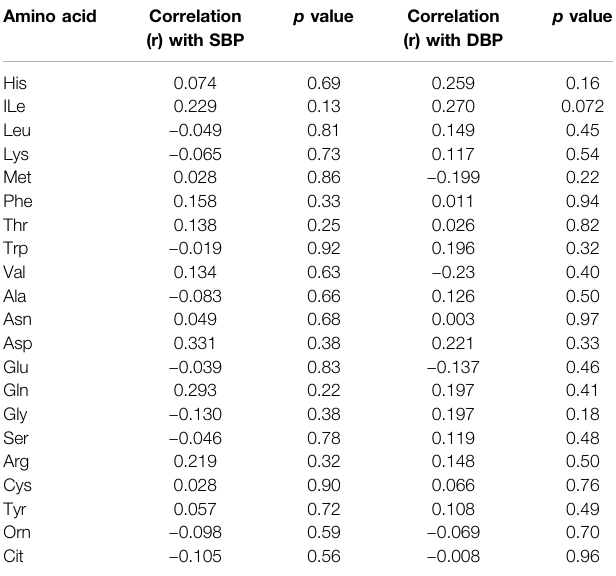
TABLE 6 | Correlation analysis between blood pressure and amino acids concentrations in T2D. Amino acid Correlation (r) with SBP